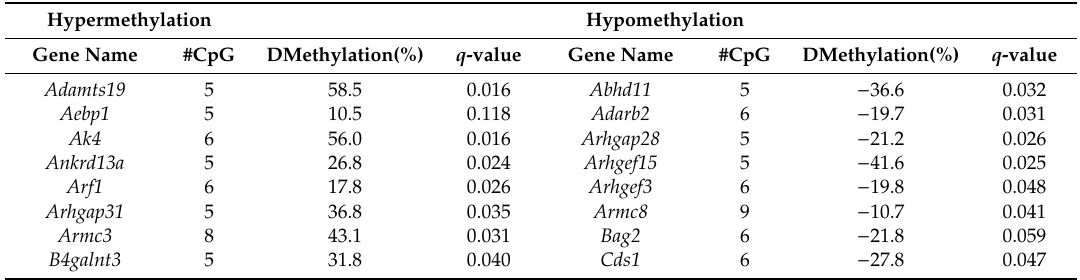
Figure 1. DNA methylome of the postnatal day (P) 15 rat hippocampus. ( a ) An unsupervised clustering heat map of 1000 randomly selected loci showing an absence of bias in global methylation between iron-sufficient (IS) and iron-deficient (ID) hippocampi. Each row in the heat map corresponds to data from a single locus. The branching dendrogram at the top corresponds to the relationships among samples. Hyper- and hypomethylation are shown on a continuum from red to green, respectively. ( b ) Heat map of differentially methylated regions (DMRs) showing significant differences in cytosine methylation between IS (labeled C1-3) and ID (labeled ID1-3) hippocampi . Each row in the heat map corresponds to data point from a single locus, whereas columns correspond to individual samples. The branching dendrogram corresponds to the relationships among samples, as determined by clustering using the 229 identified DMRs. Hyper- and hypomethylation are shown on a continuum from red to green, respectively. ( c ) Pie chart representing the location and proportion of DMRs. The gene body included exons and introns. The promoter was limited to 15 kb upstream from the transcriptional start site. The 5'-untranslated region began at the transcription start site and ended before the initiation sequence. The intergenic region is comprised of the regions not included in the above defined regions.